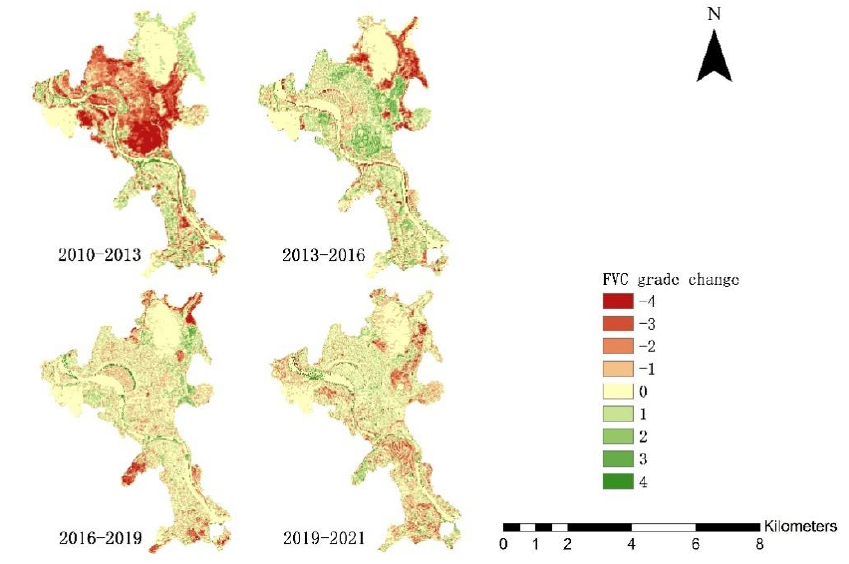
Figure 13. FVC grade change chart.